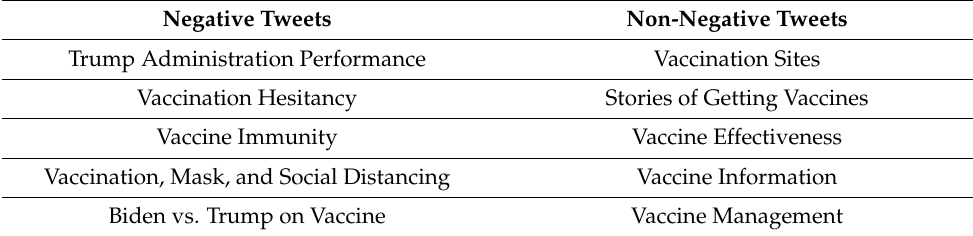
Table 3. Top-5 Topics of Negative and Non-Negative